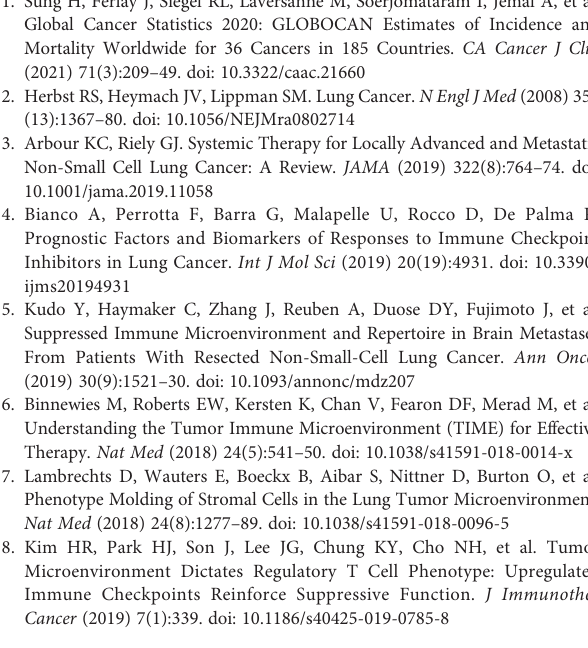
Supplementary Figure S2 | Identi fi cation of differences in the spatial distribution of immune cells within tumor nest and tumor stroma using Kruskal – Wallis test. * P < 0.05, ** P < 0.01, *** P < 0.001. ns, no signi fi cant difference. Supplementary Figure S3 | Several immune biomarkers signi fi cantly associated with disease-free survival ( p < 0.05) are selected, and T -test is performed in the identi fi cation of in fi ltration distinction across clinical stage, T stage, and N stage in the tumor nest (A) and tumor stroma (B) . Supplementary Figure S4 | Kaplan – Meier curves of three immune-related risk score (IRRS) subgroups of the entire cohort (A) . Receiver operating characteristic curve (B) and time-dependent area under curve (C) estimating the prognostic performance of IRRS. Box plots present the in fi ltration disparities of three IRRS subgroups in the tumor nest (D) and tumor stroma (E) . Supplementary Figure S5 | Kaplan – Meier curves of three immune-related risk score (IRRS) subgroups of the testing cohort (A) . Receiver operating characteristic curve (B) and time-dependent area under curve (C) estimating the prognostic performance of IRRS. Box plots present the in fi ltration disparities of three IRRS subgroups in the tumor nest (D) and tumor stroma (E)